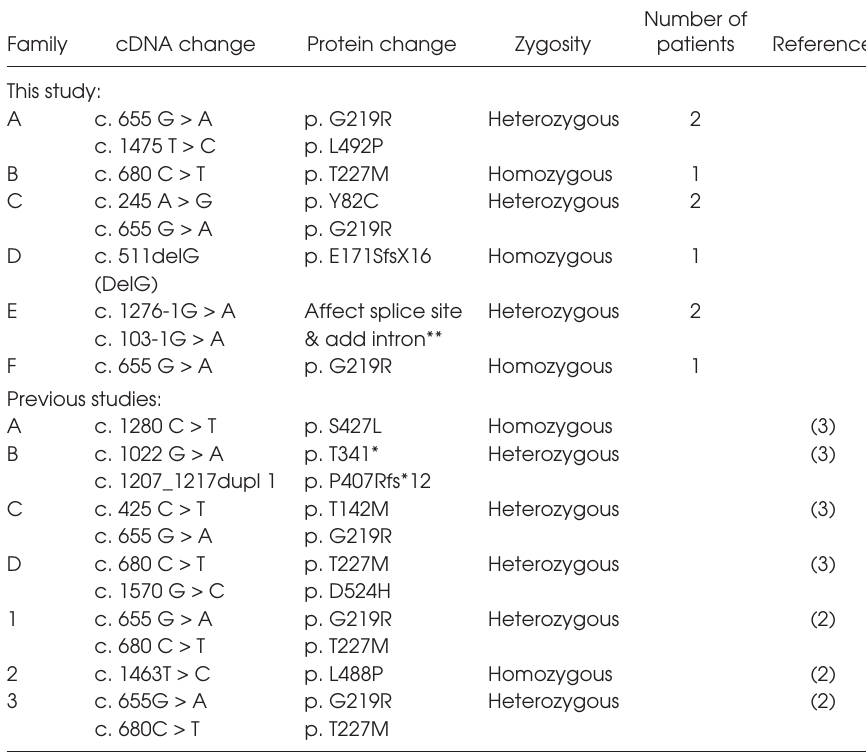
table 1. SLC13A5 mutations associated with epilepsy. Family cDNA change Protein change Zygosity